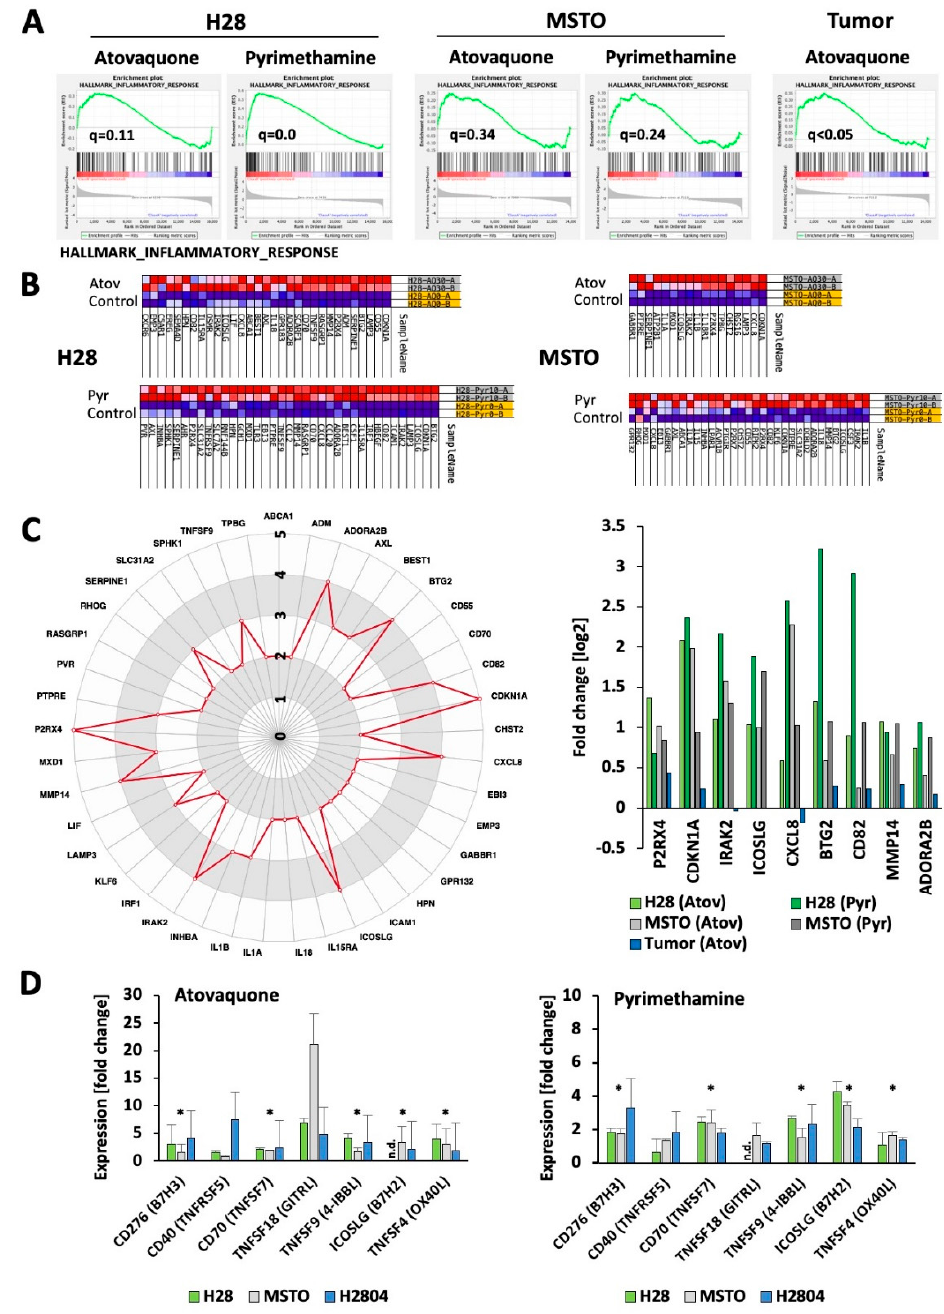
Figure 5. Atovaquone and pyrimethamine regulate immune pathway genes. ( A ) Enrichment plots of the Hallmark Inflammatory Response pathway and q-values (FDR approach) for different models treated with STAT3 pathway inhibitors, as indicated. ( B ) Enriched genes within the Hallmark Inflammatory Response pathways in H28 and MSTO-211H (MSTO) treated with either atovaquone (30 mM) or pyrimethamine (10 mM) are shown (upregulated genes—blue, downregulated genes—red). ( C ) Genes with the Hallmark Inflammatory Response pathway that are present in at least two of the five models are shown and scored according to their presence in each model (left). The relative changes in RNA expression in response to atovaquone (Atov) or pyrimethamine (Pyr) for genes that are present in at least four models are indicated (right). ( D ) The expression of additional immune pathway genes in response to 30 μ M atovaquone or 10 pyrimethamine for 24 h in H28, MSTO-211H (MSTO) or H2804 cells was determined by RT-PCR (* significant differences with p < 0.05).